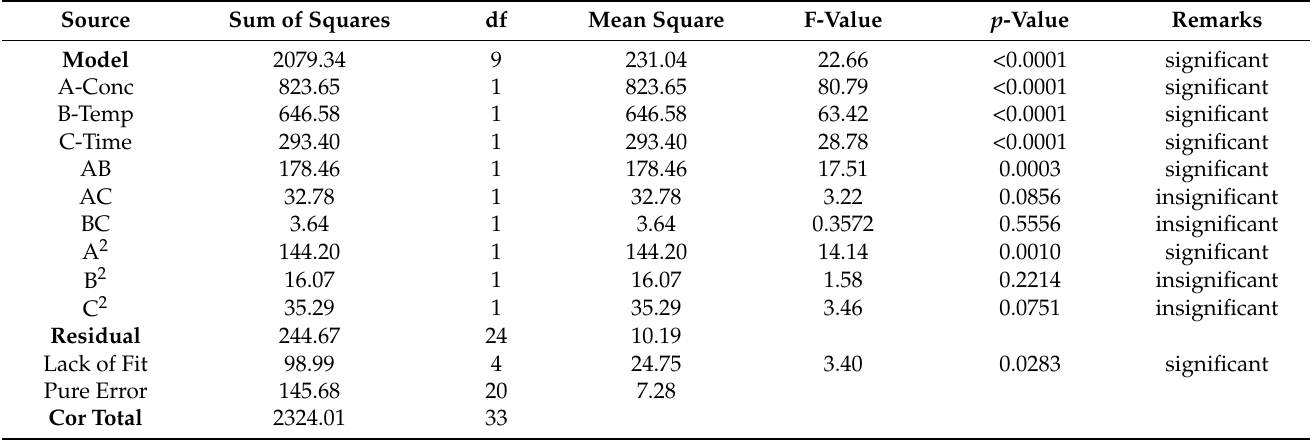
Table 7. ANOVA for Er